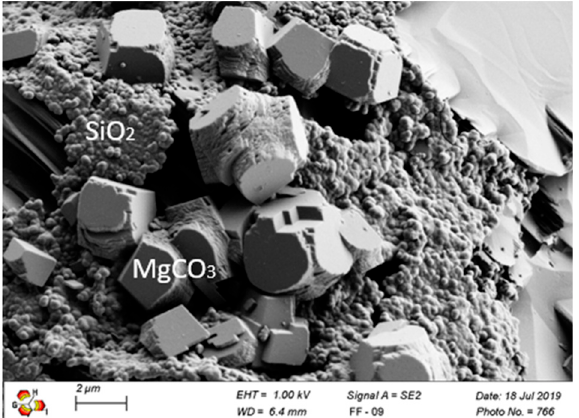
Figure 6. Typical scanning electron microscope (SEM) analysis of carbonated product at 175 °C, 71.5 bar and 4 h (20–63 µm).